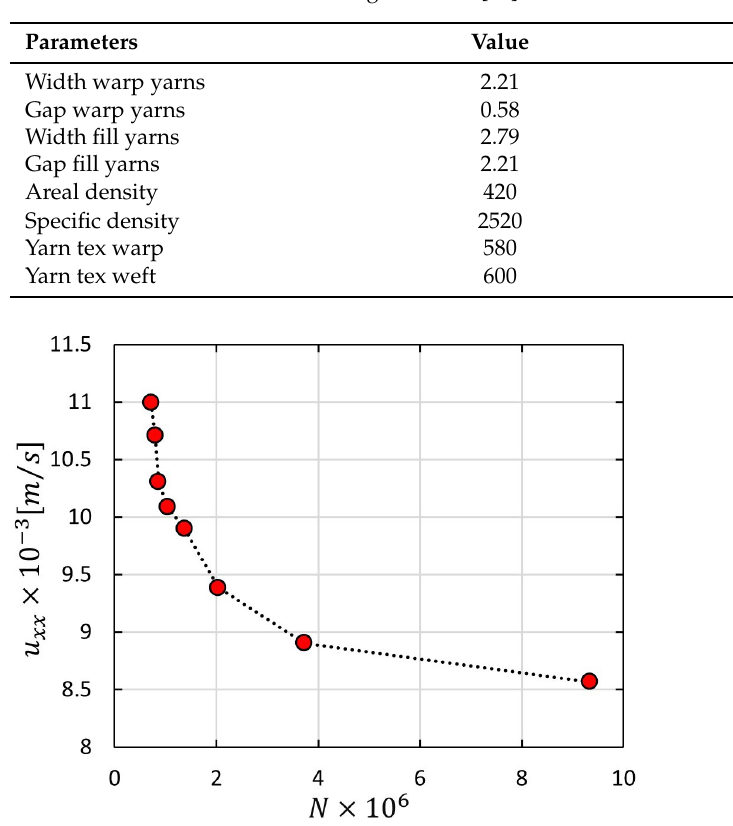
Figure 5. Mesh dependency study for channel flow case ( φ s = 0.44).